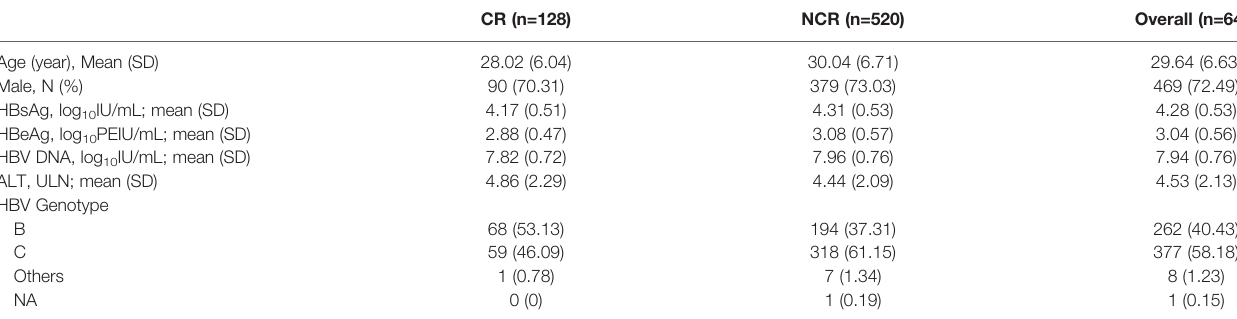
TABLE 2 | Baseline clinical characteristics of patients treated with Peg-IFN a